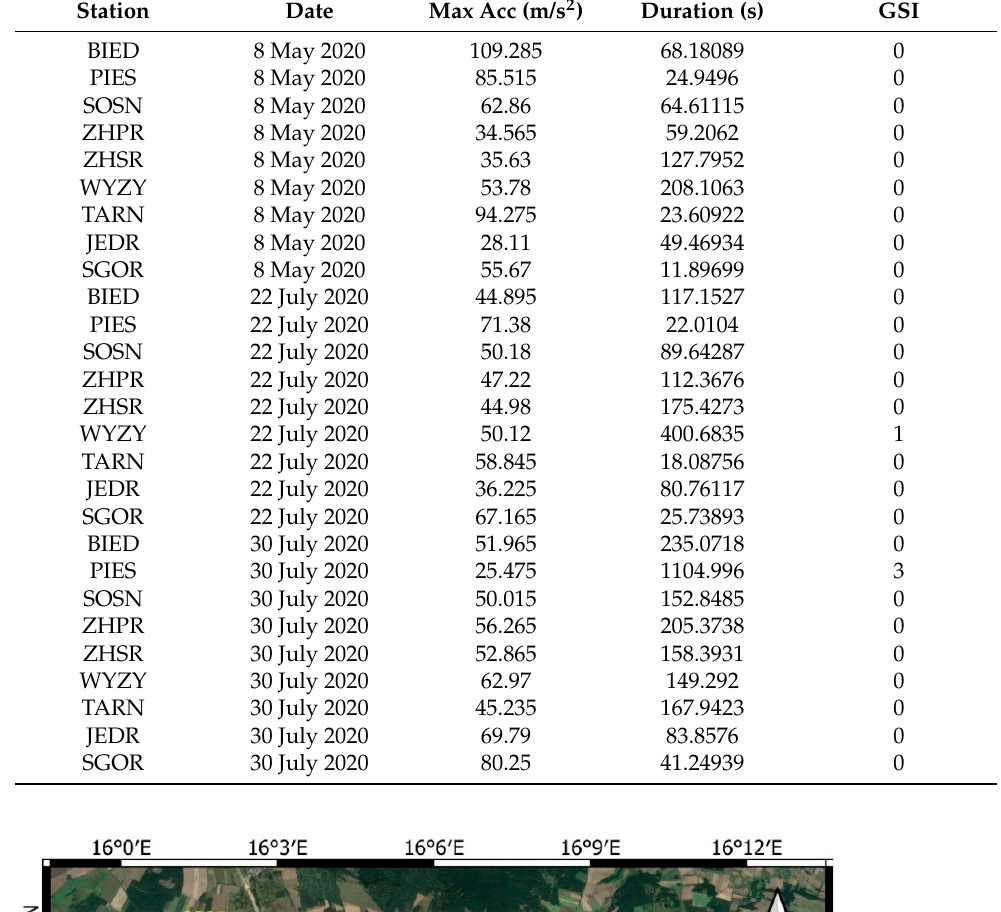
Table 4. Summary of the main seismic events recorded by the seismometer stations.